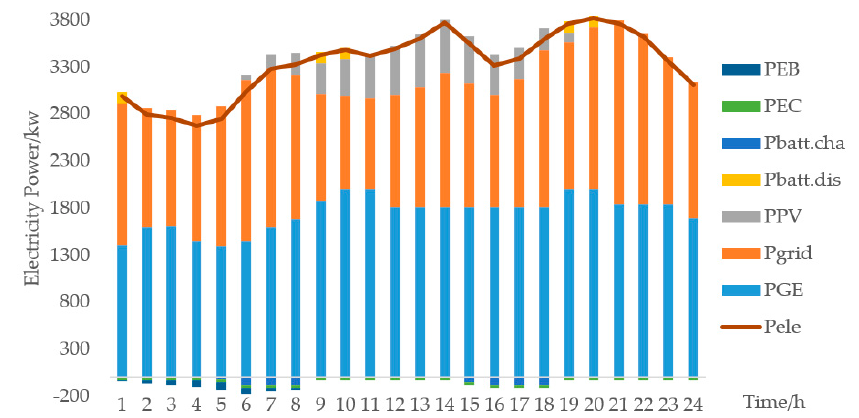
Figure 14. Power output diagram of various equipment before single time scale in summer.